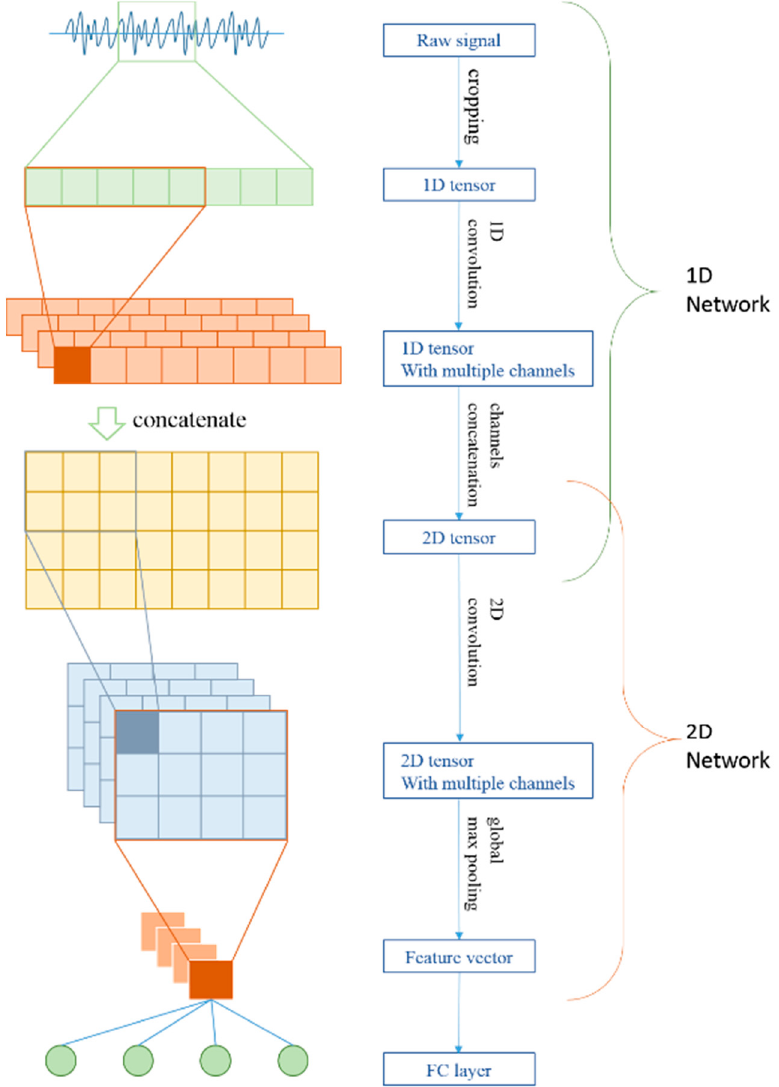
Figure 1. Network structure for ESR classification. The 1D and 2D networks are serialized together but could also work alone to be fit with different situations.